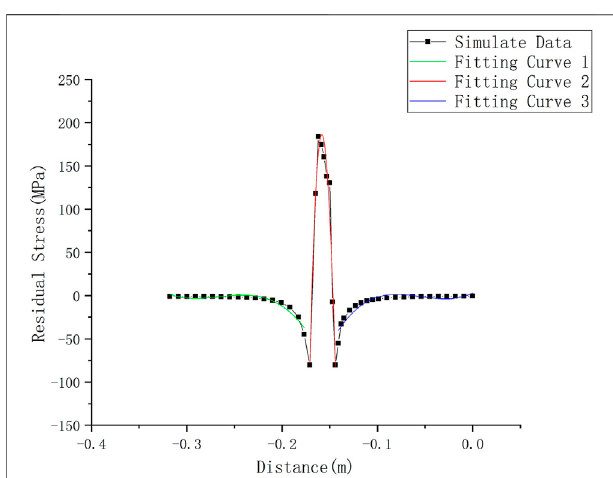
FIGURE 14 | Fitting curve of residual stress σ z